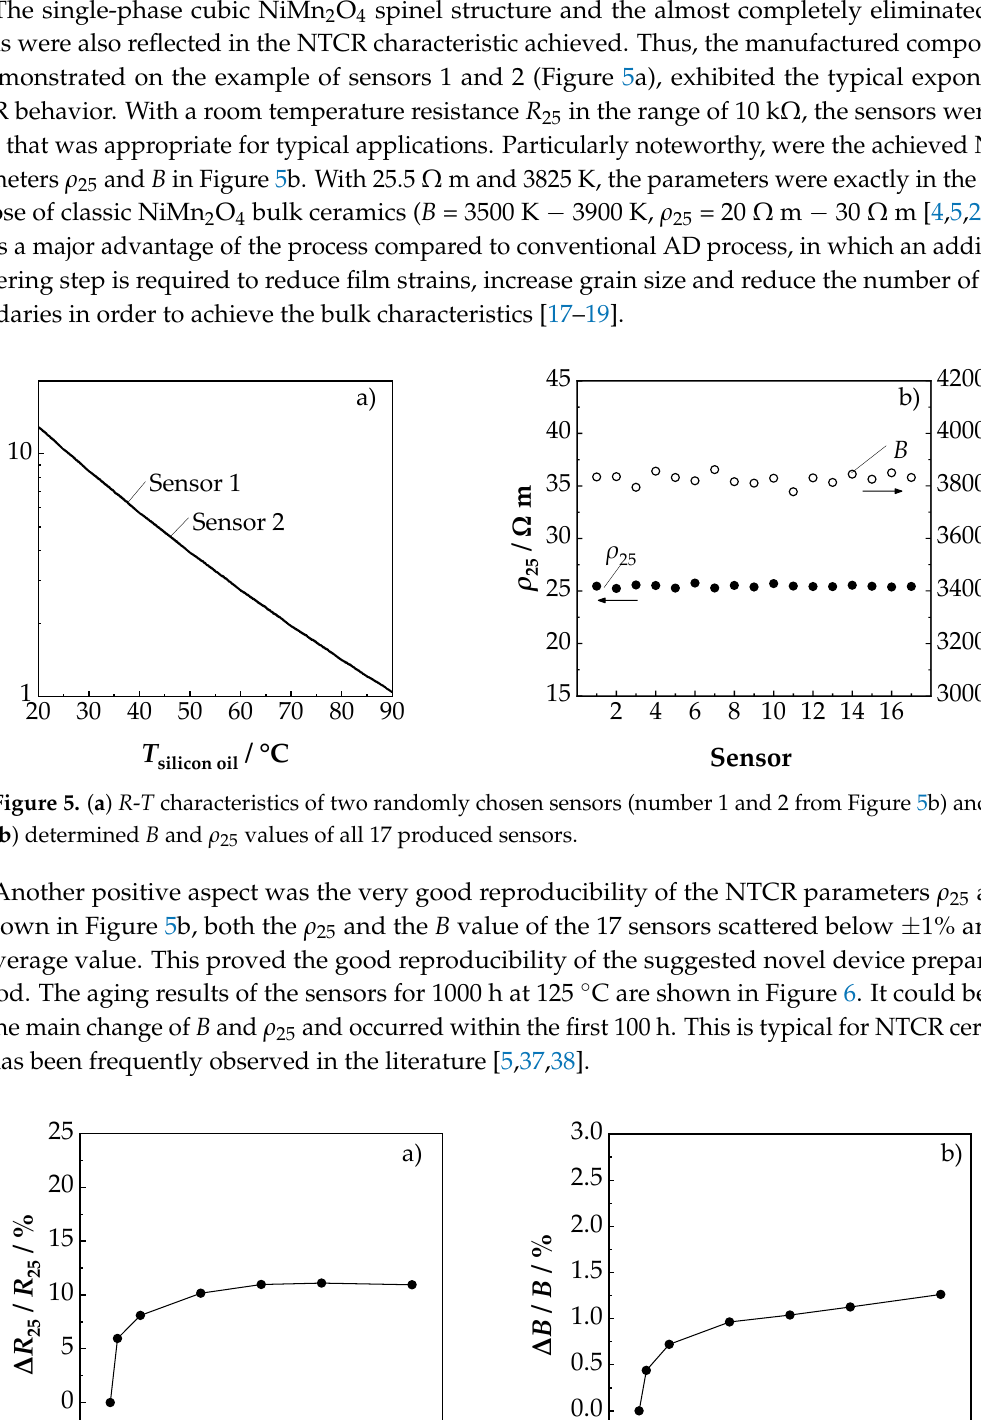
Figure 6. Influence of aging for 1000 h at 125 °C on ( a ) R 25 value and ( b ) B value.